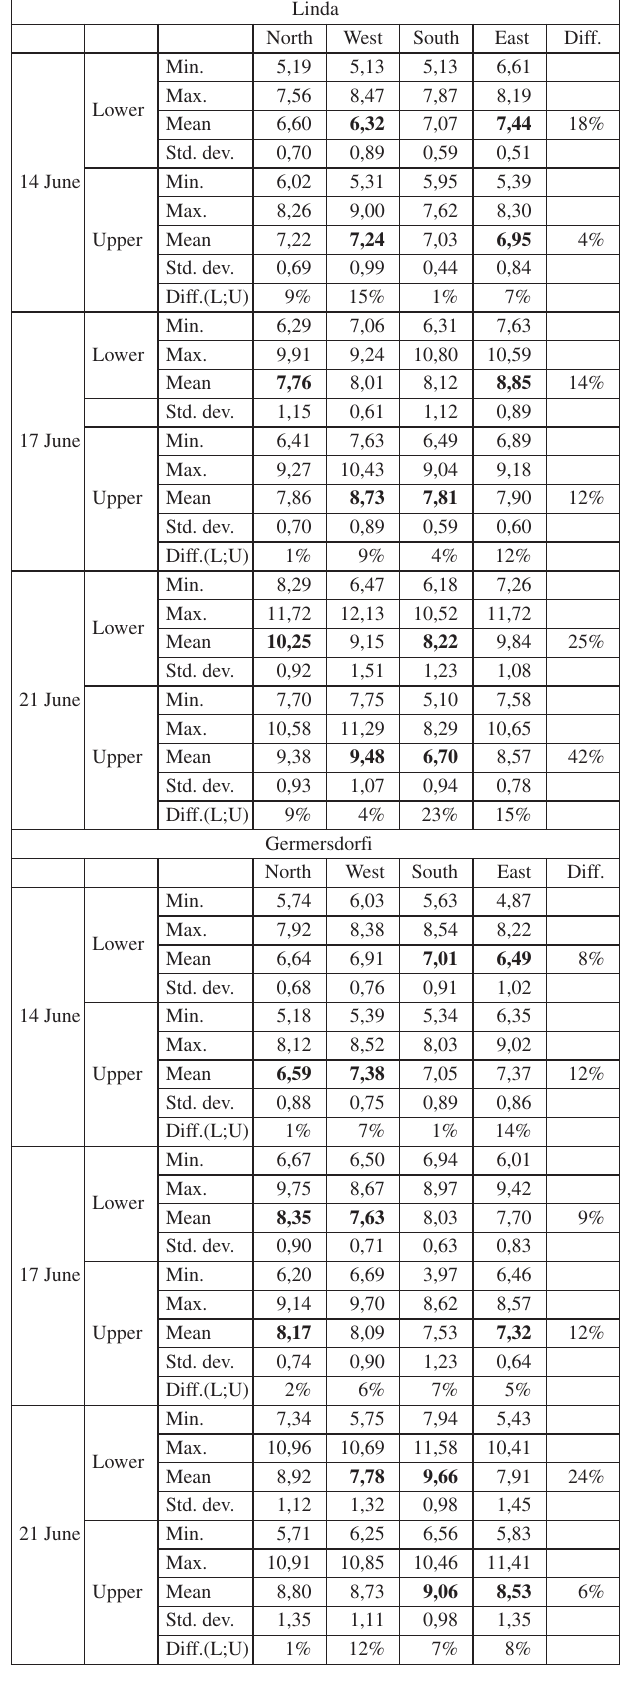
Table 2: The values for the individual fruit mass